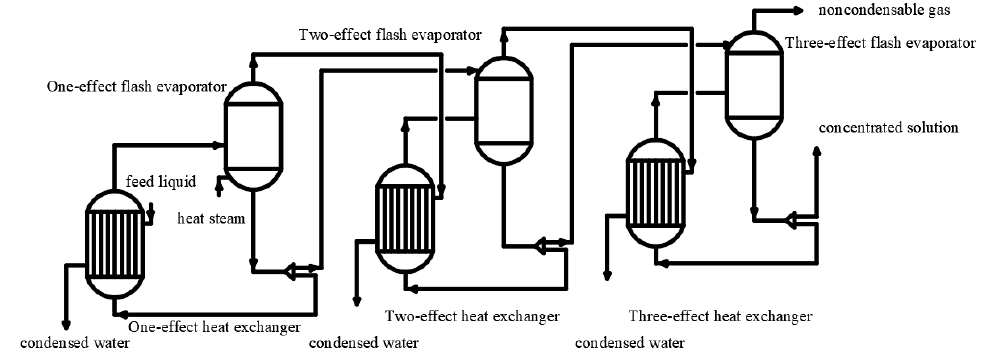
Figure 2. Multiple effect distillation